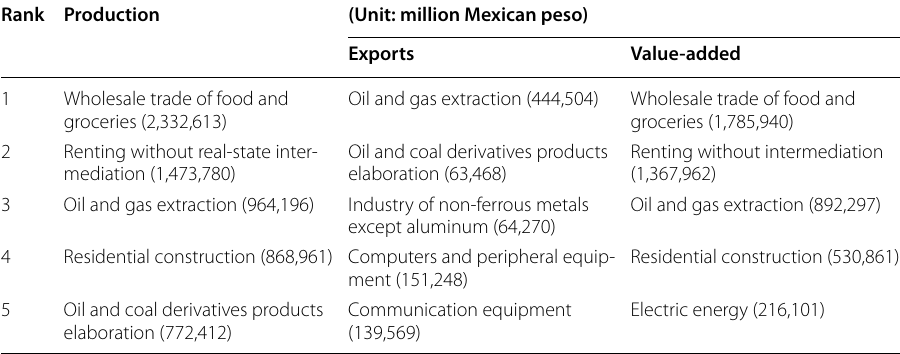
Table 2 Top ranked sectors according to macroeconomic variables (2008). Source: Results from authors